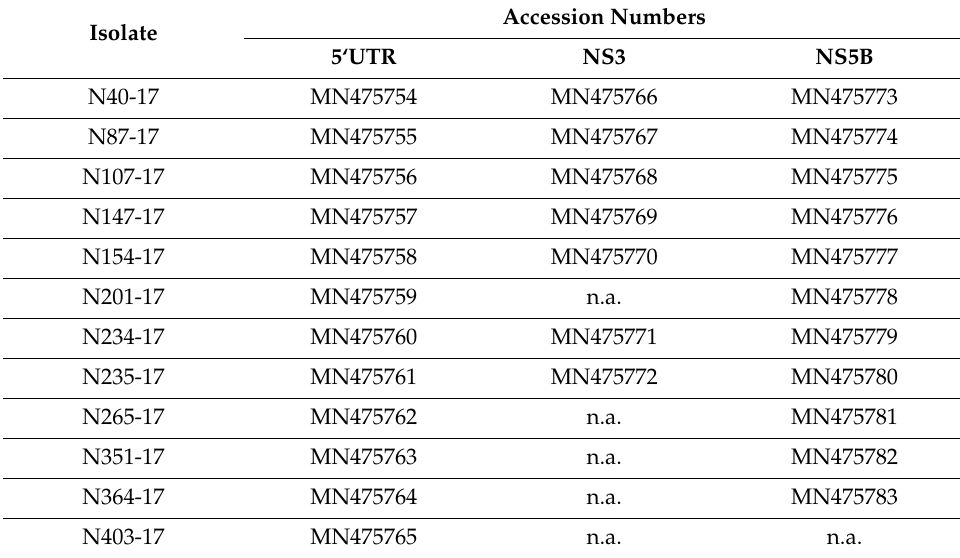
Table 3. The newly identified sequences which were submitted to NCBI and assigned with accession numbers. n.a.—not